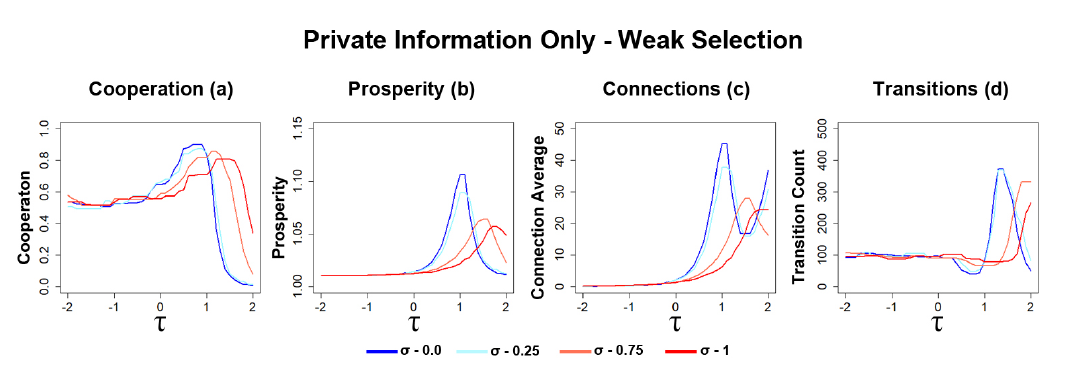
Figure 6. Increasing diversity of opinion leads to less transitions and connections, but also less cooperation. The plots visualise and compare the metrics of cooperation, prosperity, average connectivity and number of transitions for differing levels of opinion diversity. As diversity is increased, the number of transitions and connections decreases at various τ settings. This does appear to come at some cost for the average amount of cooperation and prosperity obtained for higher diversity. Data obtained by running the model for 10 8 steps considering only private information and a δ setting of 0.001. τ represents the decision threshold. σ represents opinion diversity. Shading represents level of standard error calculated for each dataset. Data interpolated utilising RStudio [22]. Plots produced via RStudio utilising code found in Appendix